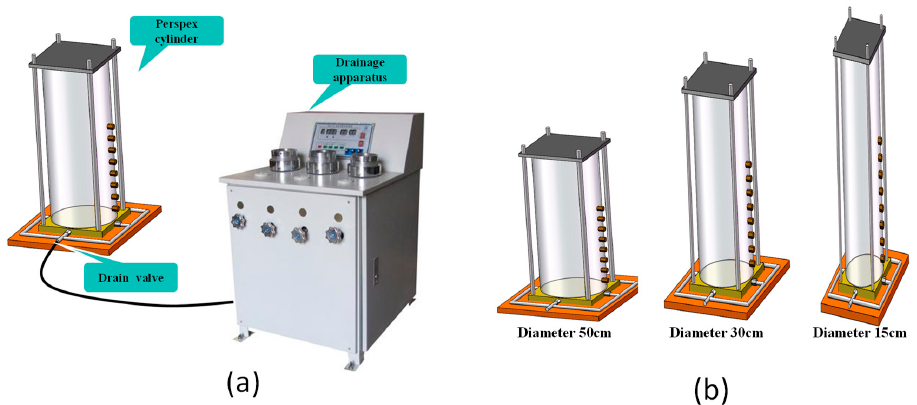
Figure 2. Filter cake air Penetration test system. ( a ) drainage apparatus and valve, ( b ) different measuring instruments adopted for the test.